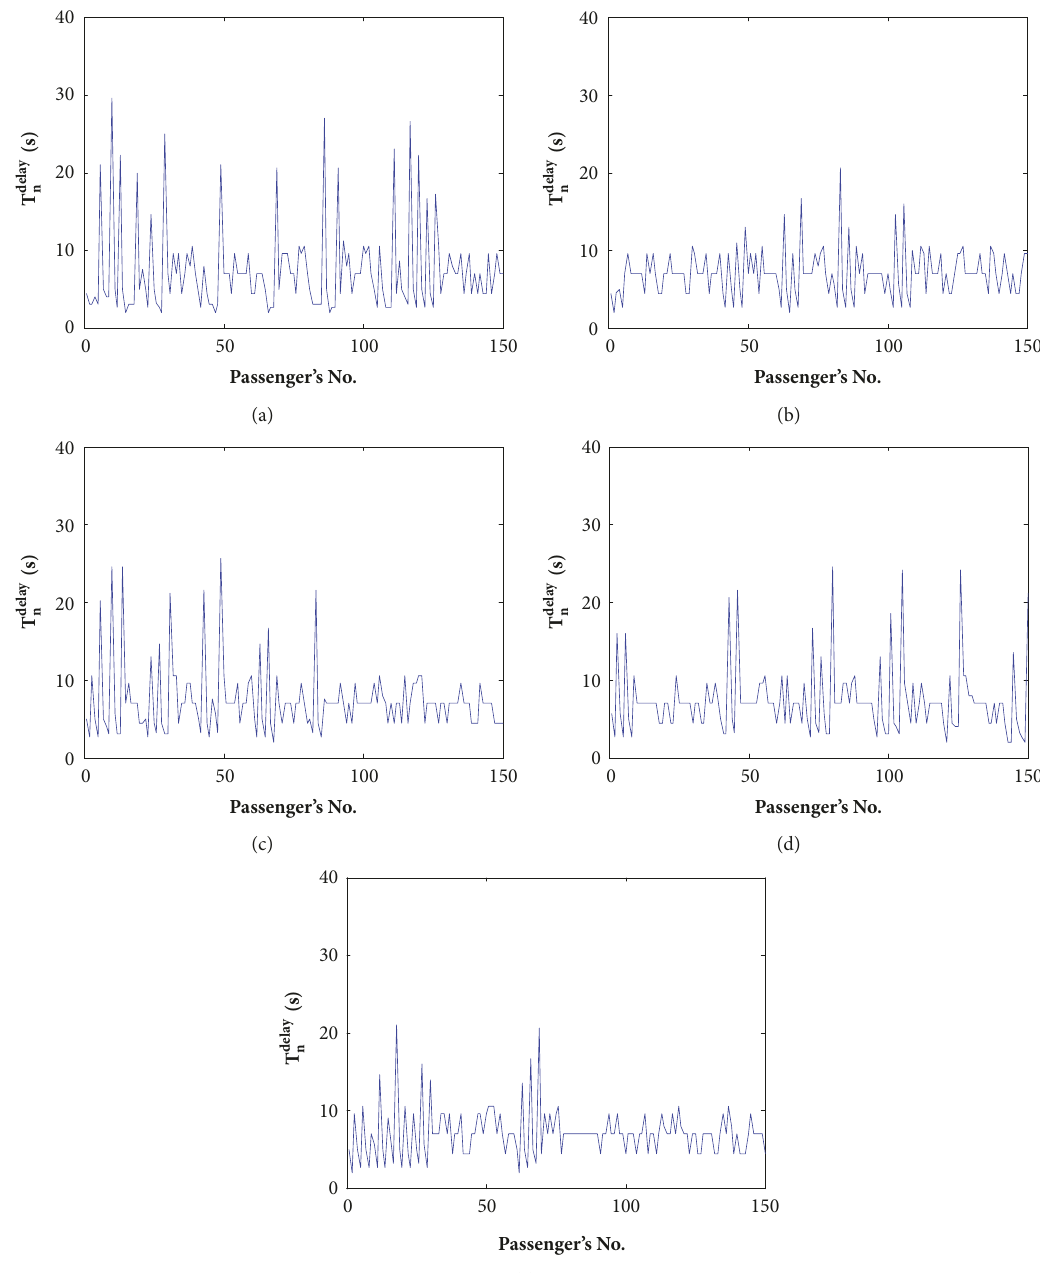
Figure 7: 𝑇 delay under different strategies during the boarding process, where (a)-(e) are, respectively, the random, BF, Wilma, Steffen, and n proposed